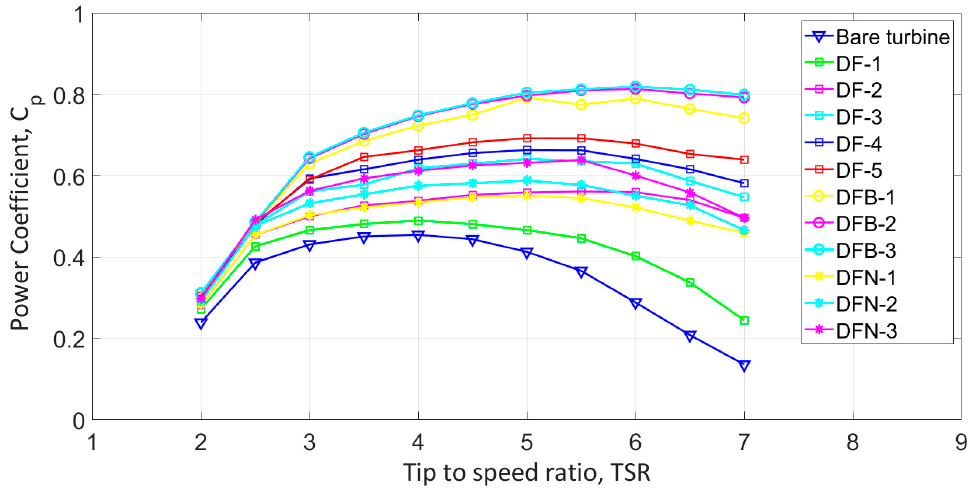
Figure 16. Power coefficients’ comparison between bare turbine and turbines with diffusers.